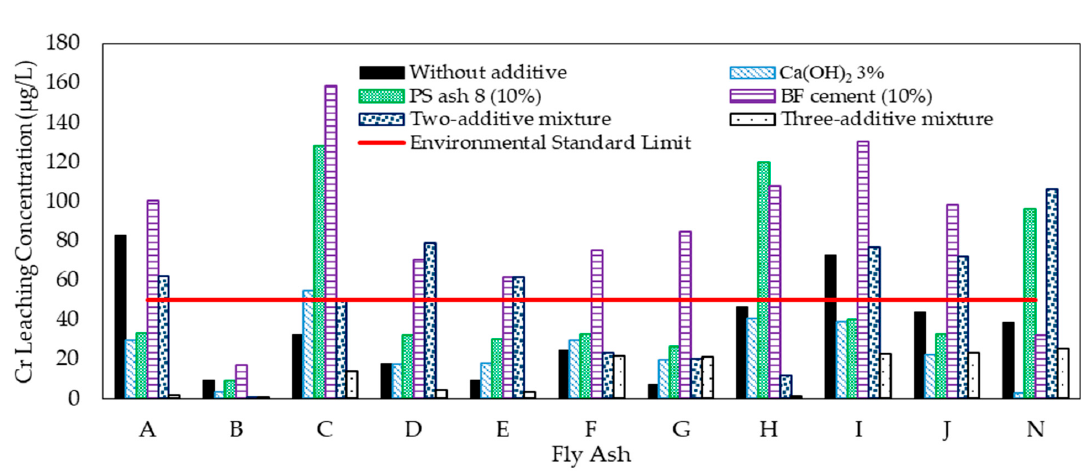
Figure 2. Effect of additive on Cr leaching concentration from coal fly ash .